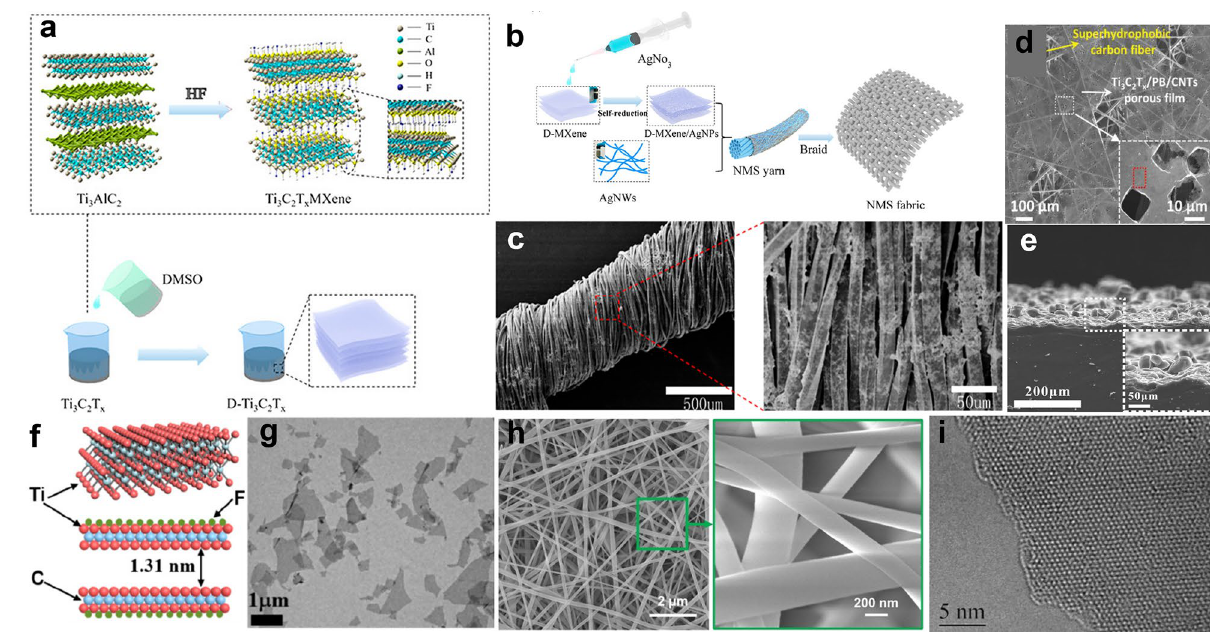
Fig. 4 The structure and fabrication process of MXene. a Scheme of HF etching Al directly, by adding proportion of the DMSO solution, the MXene nanoblocks were delaminated into nanosheets. b AgNPs reduced by Ti 3 C 2 T x mixed with AgNWs dipped into the surface of wrapped yarn modified by PDA, and c SEM image of yarns coated with MXene. Reproduced with permission [122]. Copyright (2019), American Chemi- cal Society. d SEM image of porous and ultrathin Ti 3 C 2 T x /PB and CNTs ternary film, with the inset (white box) displaying a zoomed ‐ in SEM image of the holes in the film. Reproduced with permission [123]. Copyright (2019), Wiley–VCH. e Schematic illustration of the Ti 3 C 2 crystal structure and f TEM image of MXene nanoflakes, which has thermoacoustic effect for soft MXene earphone. Reproduced with permission [124]. Copyright (2019), American Chemical Society. g SEM images showing the rough surface and side of the randomly distributed microspinous MXene-based PDMS obtained using abrasive paper. Reproduced with permission [120]. Copyright (2020), American Chemical Society. h SEM image of the MXene composite nanofibrous scaffolds for wearable pressure sensor and the inset showing the morphology at a higher magni- fication. Reproduced with permission [125]. Copyright (2020), American Chemical Society. i Atomic resolution TEM image of a suspended Ti 3 C 2 T x nanosheet from top view [121]. Copyright (2020), Nature Publishing